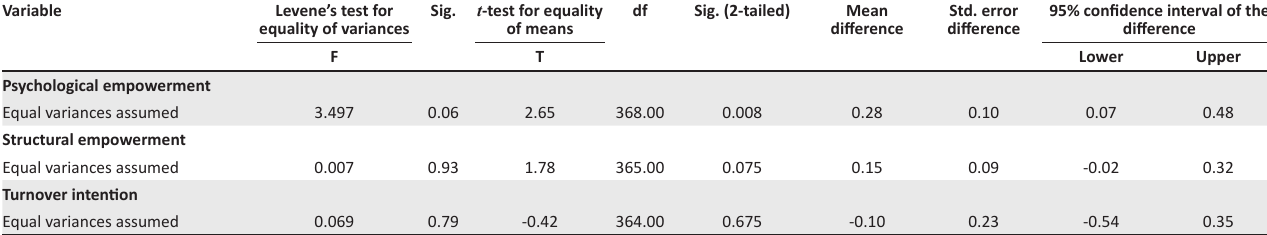
TABLE 7: Independent-samples t -test: Gender on structural empowerment, psychological empowerment and turnover intention. Variable Levene’s test for Sig. t -test for equality equality of variances of means